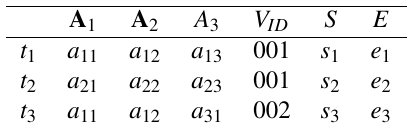
Table 11 contains an example instance.